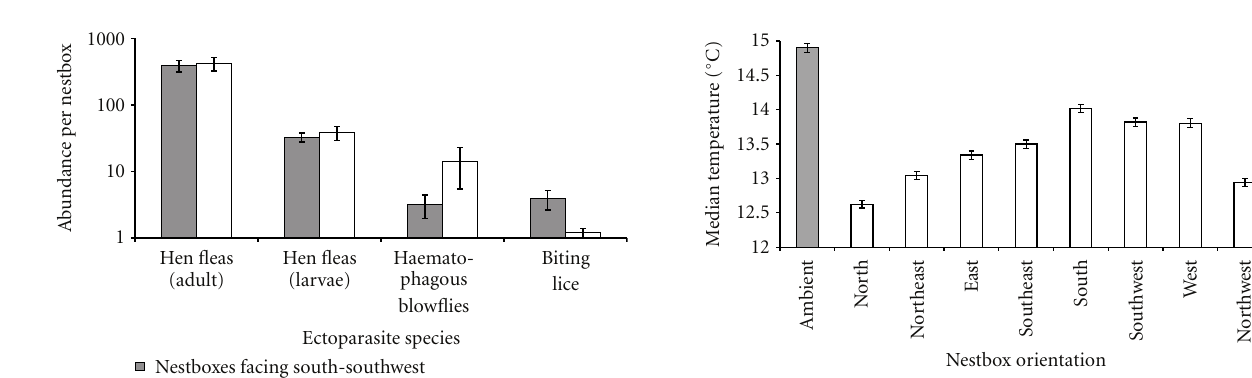
Figure 2: Mean internal nestbox temperatures according to orien- tation. Measurements were taken during the hottest part of the day (13.00–17.00 BST) during the 2006 breeding season ( n = 12, 600 datapoints). Error bars =